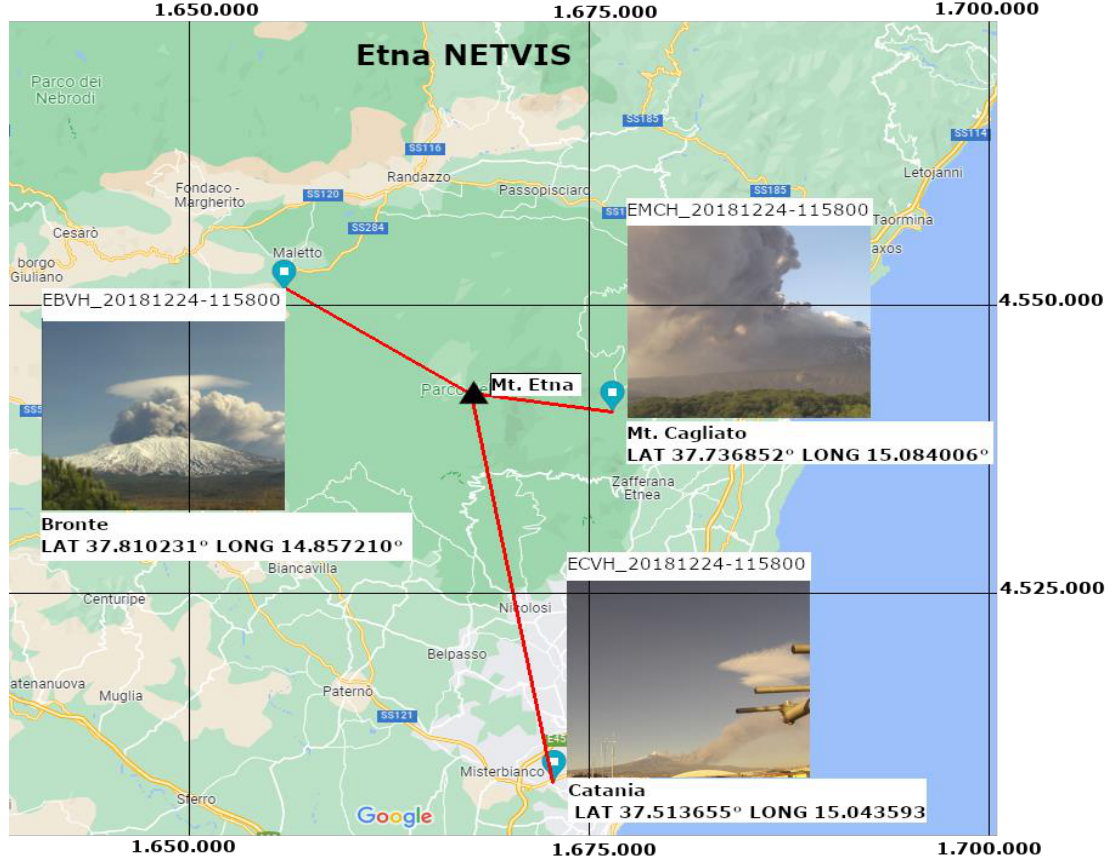
Figure 3. Etna_Netvis surveillance network.